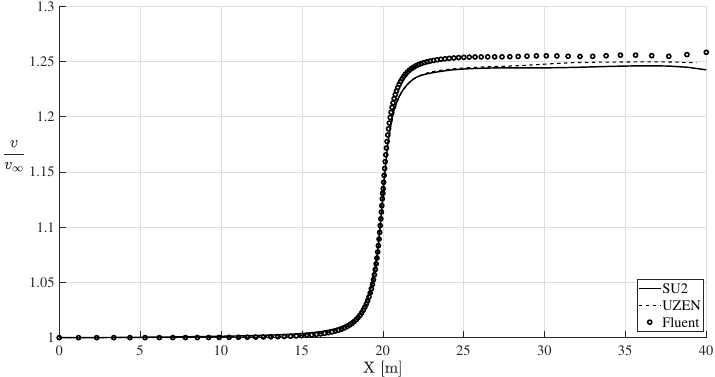
Figure 11. X component velocity profile along streamline y = 0.6 m at z = 0 m section.